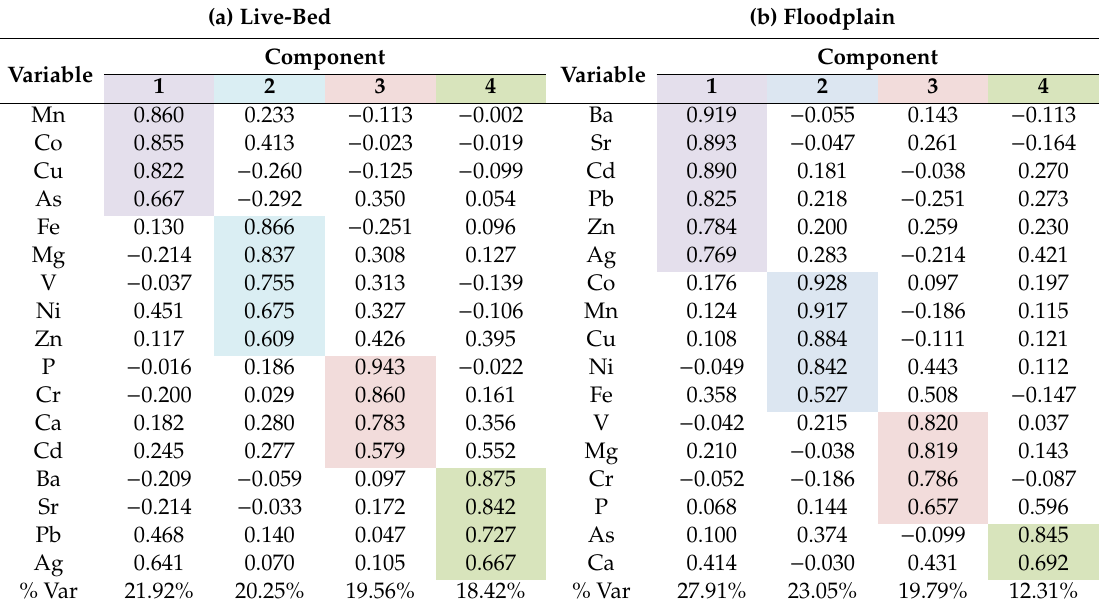
Table 3. Principal component loadings obtained in principal component analysis of the element concentrations in the live-bed ( a ) and in the floodplain ( b